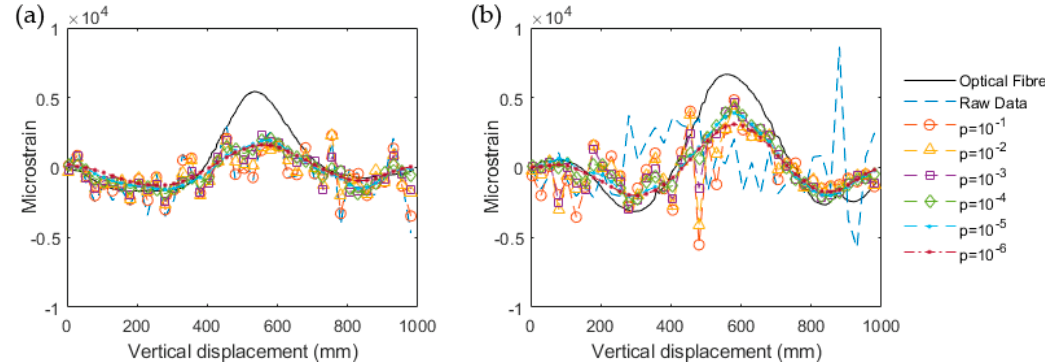
Figure 11. OOP deformation test Step 5: Strain along the vertical line ( a ) at 800 mm and ( b ) at 1000 mm for different p parameters, no filter, and optical fibre.